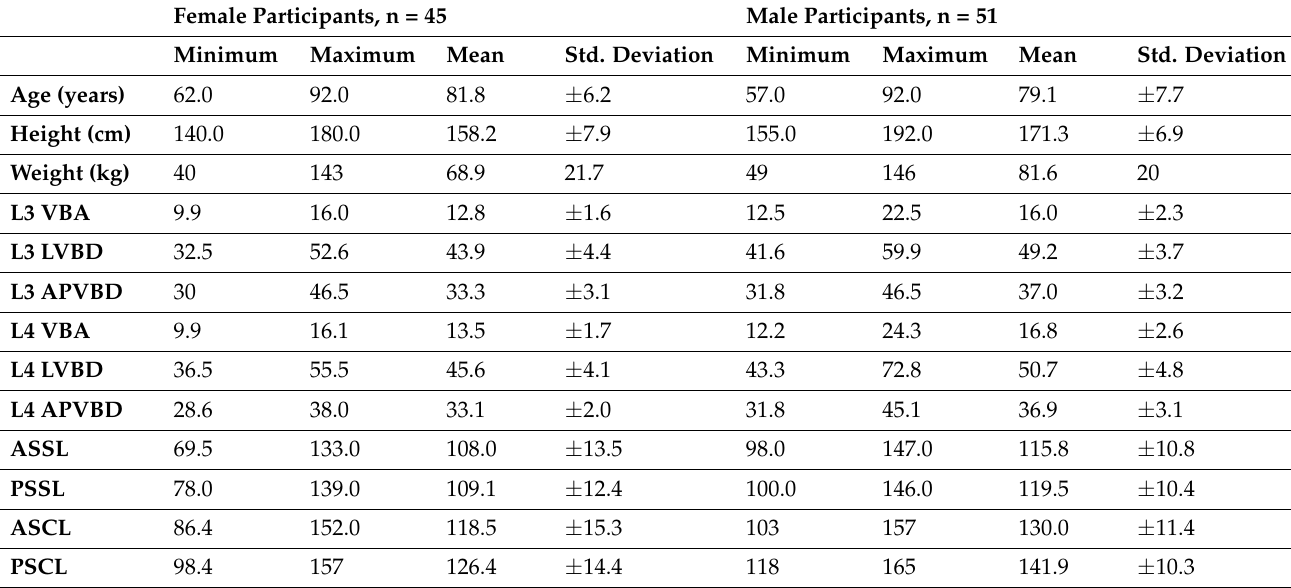
Table 3. Descriptive statistics of all variables.